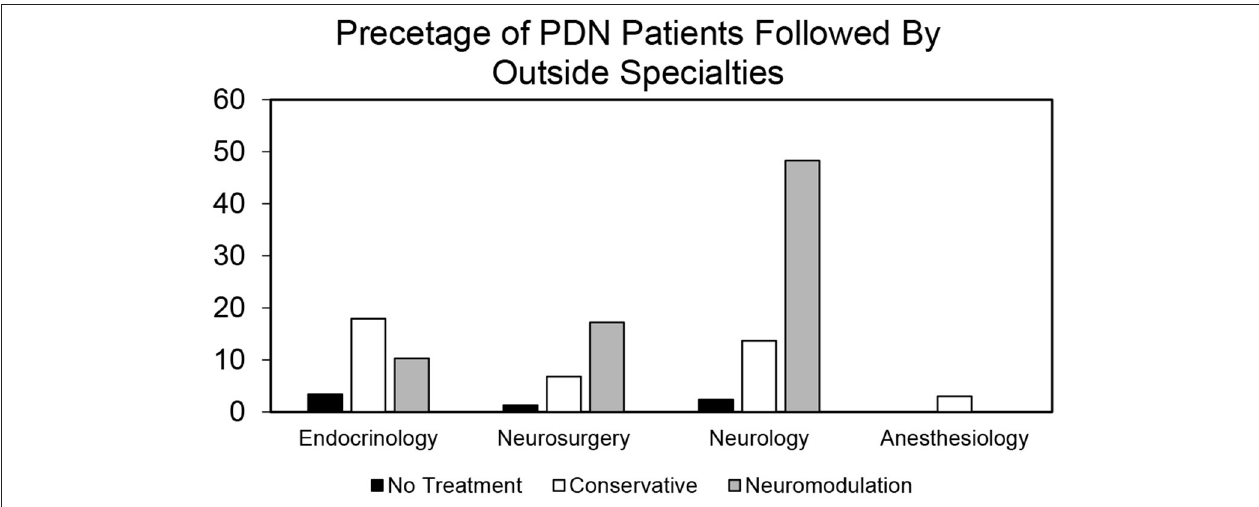
FIGURE 5 | Proportion of patients by provider type who are followed by other specialties in no treatment, conservative treatment, and neuromodulation cohorts. Histogram of percentage of patients from all the three cohorts that are followed by other specialties in addition to their primary provider as determined by our bioinformatics